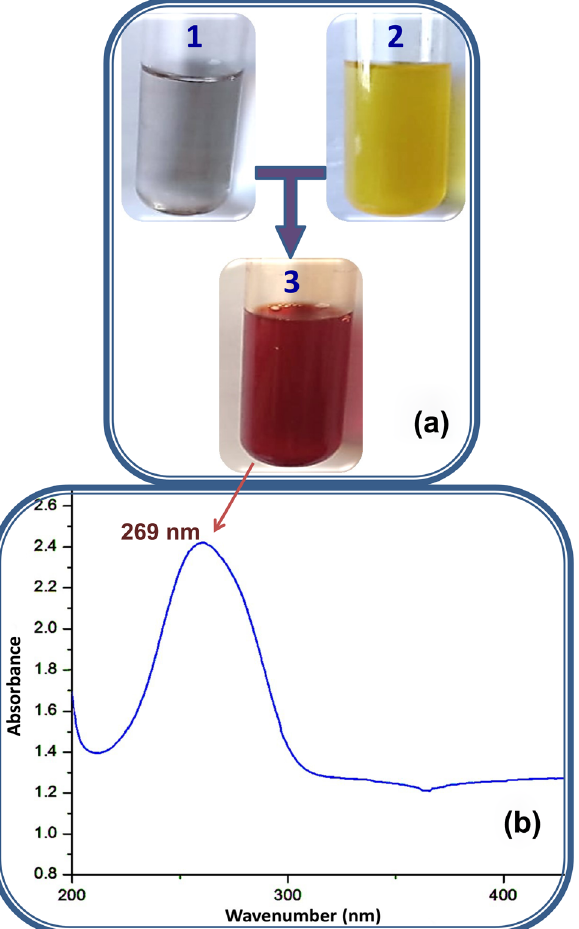
Figure 1: Optical and UV spectral analysis of synthesized nano - selenium with nano - curcumin including: ( 1 in a ) NC, ( 2 in a ) sodium selenium solution, ( 3 in a ) NC/NSe composite; ( b ) UV - Vis spectrum of biosynthesized Se NPs with NC.